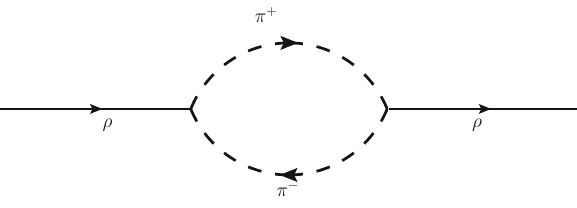
Fig. 1 Self-energygraphofthe ρ -mesonfromatwo-pionintermediate state in the presence of a magnetic field of arbitrary strength